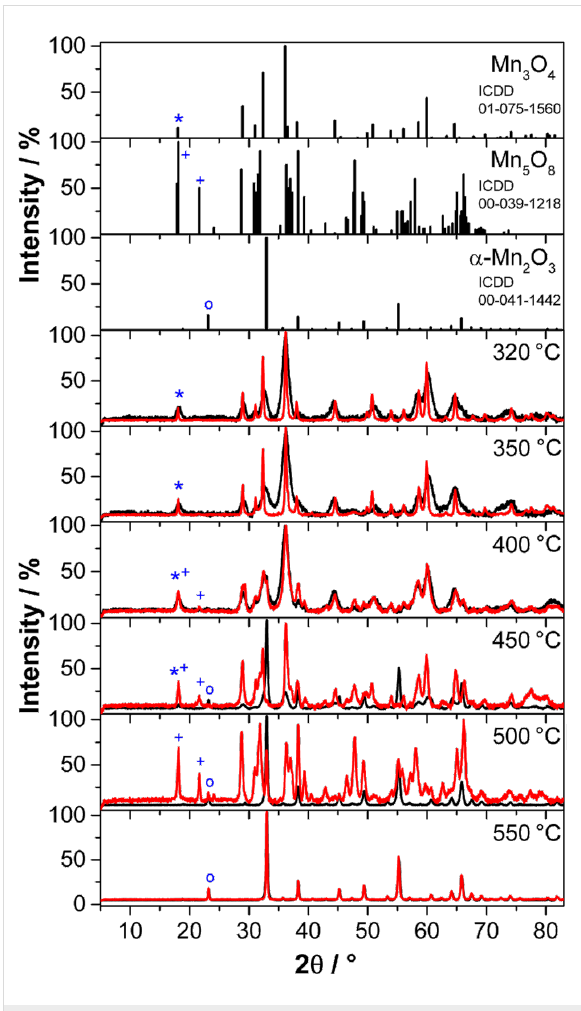
Figure 4: Powder XRD patterns of the manganese oxide particles obtained after calcination of the Mn(II) glycolate for 2 h at different temperatures in an Ar (black) and an O 2 (red) flow of 50 NL/h. Refer- ence patterns are depicted at the top for Mn 3 O 4 ( * ), Mn 5 O 8 (+) and α -Mn 2 O 3 ( ○ ), where the symbols indicate the respective low-angle